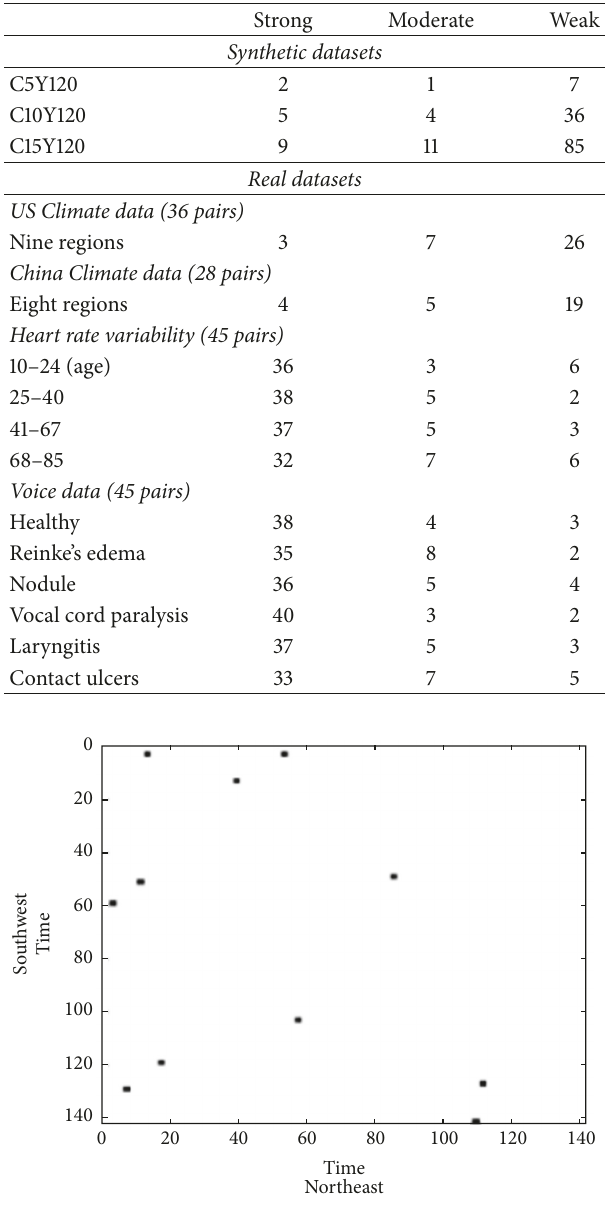
Table 5: CPR binning table for real and synthetic datasets.